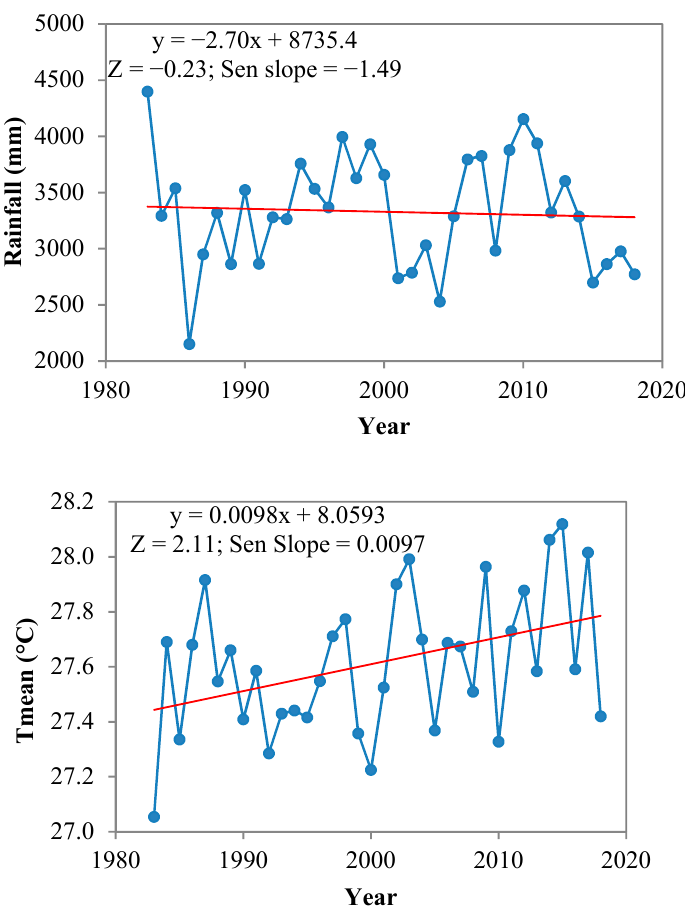
Figure 4. Trends in annual rainfall and mean temperature of Goa (1983–2018). Regarding the maximum temperature, there was a slight variation in temperature from 1983–2018, and an increasing trend was observed (0.0098 ◦ C/year). The lower mean maximum temperature (Figure 5) was observed in the year 1983 (31.2 ◦ C). The calculated av- erage Sen’s slope for maximum temperature indicated the increasing trend (+0.04 ◦ C/year). Likewise, the result of the Pettitt test showed a rising shift in the temperature; the mean maximum temperature was 31.605 ◦ C before 2001; however, it increased to 31.899 ◦ C after 2002 (Figure 5). Most of the farmers (72%) perceived that there is a significant increase